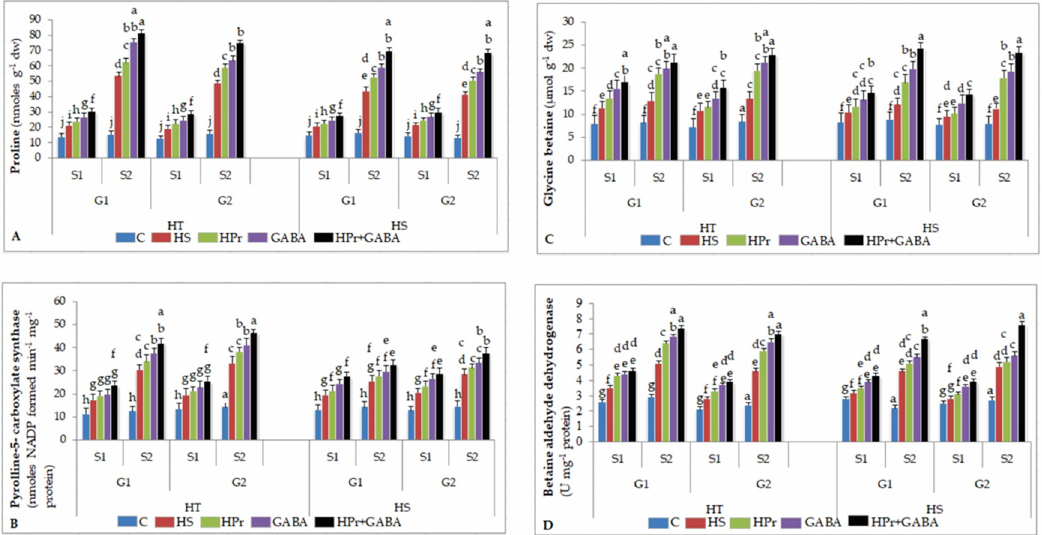
Figure 7. Effect of heat priming (HPr) and γ -amino butyric acid (GABA), applied individually or in combination (HPr+GABA) on proline ( A ) and pyrolline-5- carboxylate synthase ( B ) glycine betaine ( C ) and betaine aldehyde dehydrogenase ( D ) on heat-tolerant (G1: IG2507; G2: IG3263) and heat-sensitive (G1: IG2821; G2: IG2849) genotypes at stage 1 (S1) and stage 2 (S2) in heat-stressed (HS) lentil plants, compared to control ( C ). Vertical bars represent standard errors ( n = 3). Different small letters on the bars indicate significant differences from each other ( p < 0.05). LSD for interaction (genotypes × stages × treatments) ( p < 0.05): proline: 2.7, pyrolline-5-carboxylate synthase: 2.8, glycine betaine: 2.8, betaine aldehyde dehydrogenase: 0.19. dw = dry